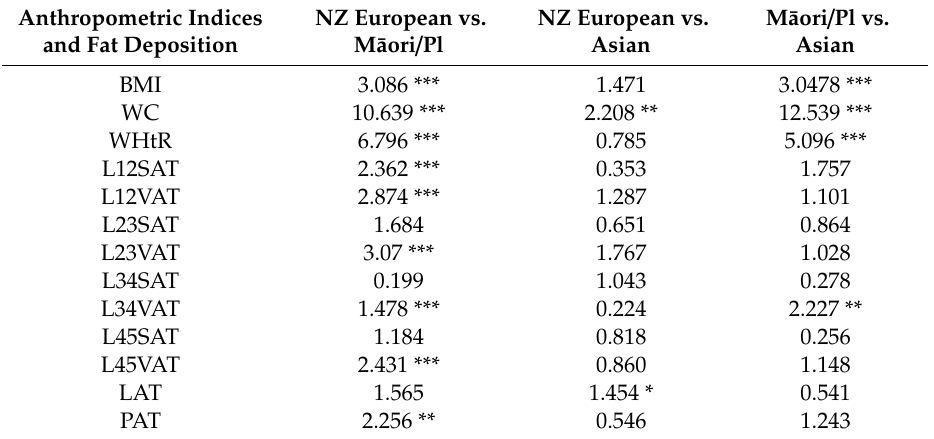
Table 2. Results of Student’s t -test for equality of means between the groups.